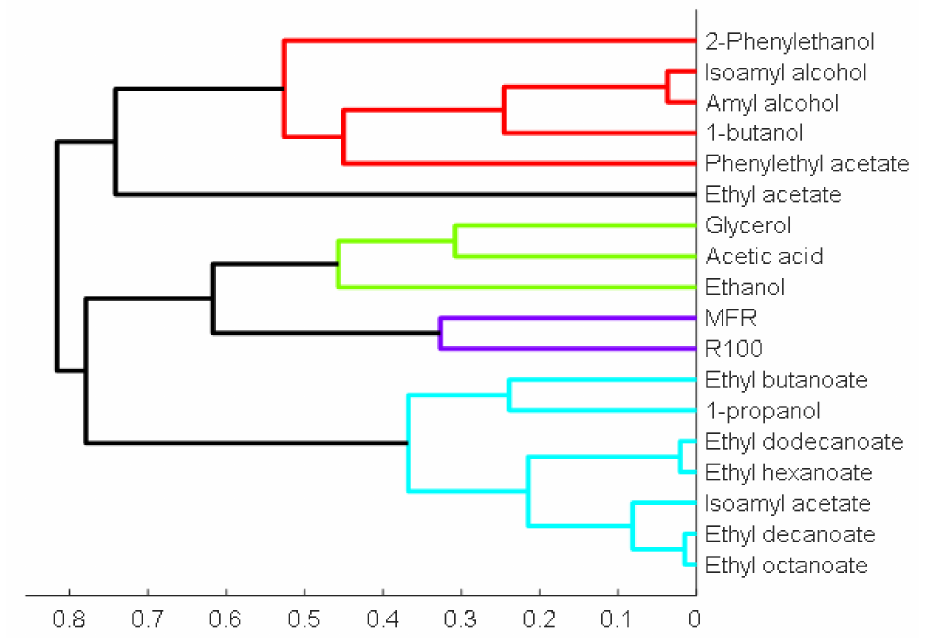
Figure 5. Dendrogram for AHC using a correlation-based distance for detecting modules of associated